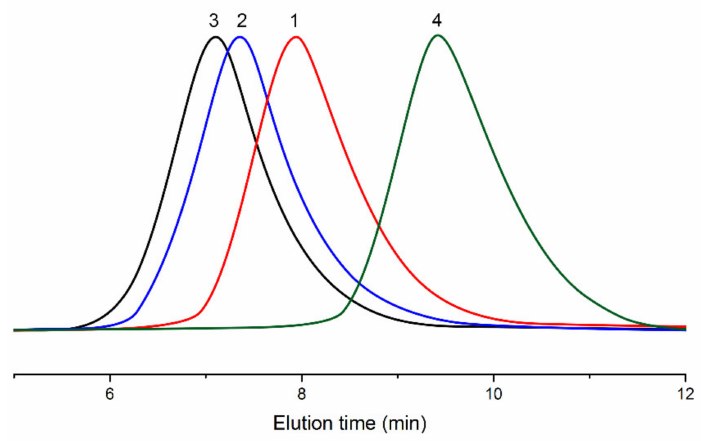
Figure 6. GPC curves: 1—polymer 1, Table S1 (Mn = 42,000, PDI = 1.23), 2—polymer 2, Table S1 (Mn = 61,000, PDI = 1.27), 3—polymer 3, Table S1 (Mn = 83,000, PDI = 1.13), 4—polymer 16, Table 2 (Mn = 11,000, PDI =